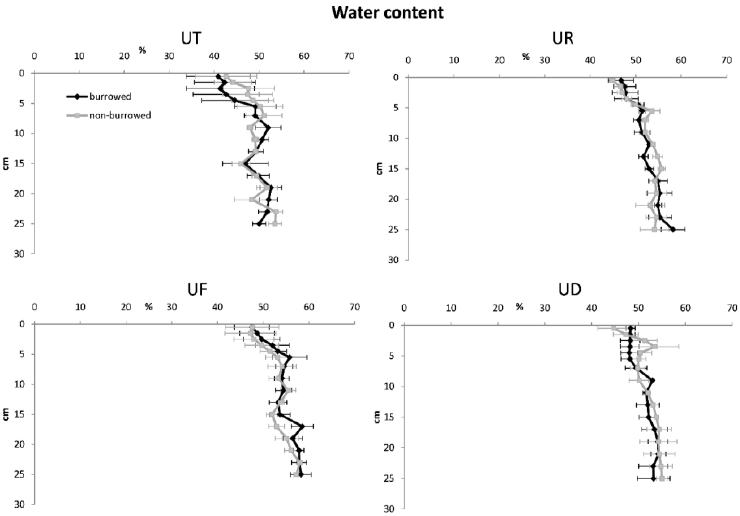
Figure 3. Vertical distribution of water content in burrowed and non-burrowed sediments of U. triangularis (UT), U. rosea (UR), U. forcipata (UF) and U. paradussumieri (UD) habitat.